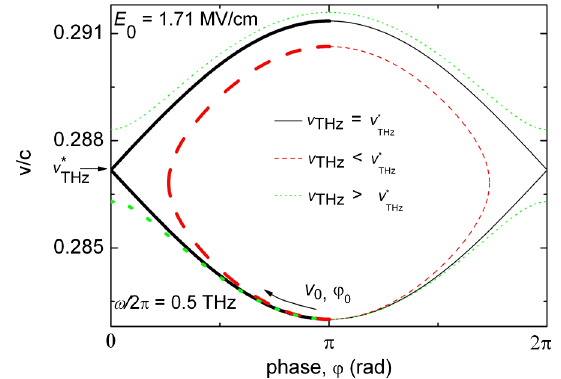
FIG. 2 . Proton velocity vs phase ϕ for v v < v (cid:3) (dashed line), and v THz THz phase velocities. The interaction within one half cycle of the field is shown by the thick part of the curves.